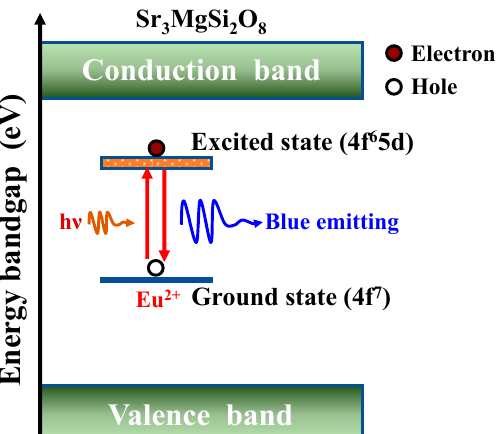
Figure 6. The electronic mechanism of the [Sr 0.99 Eu 0.01 ] 3 MgSi 2 O 8 phosphors.